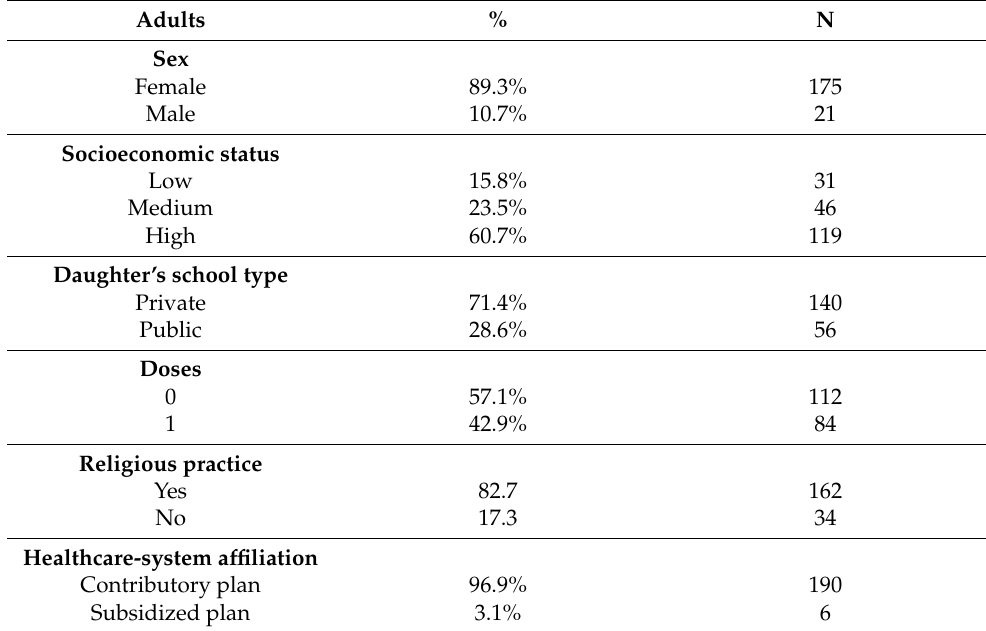
Table 1. Sociodemographic characteristics of online questionnaire participants (N =